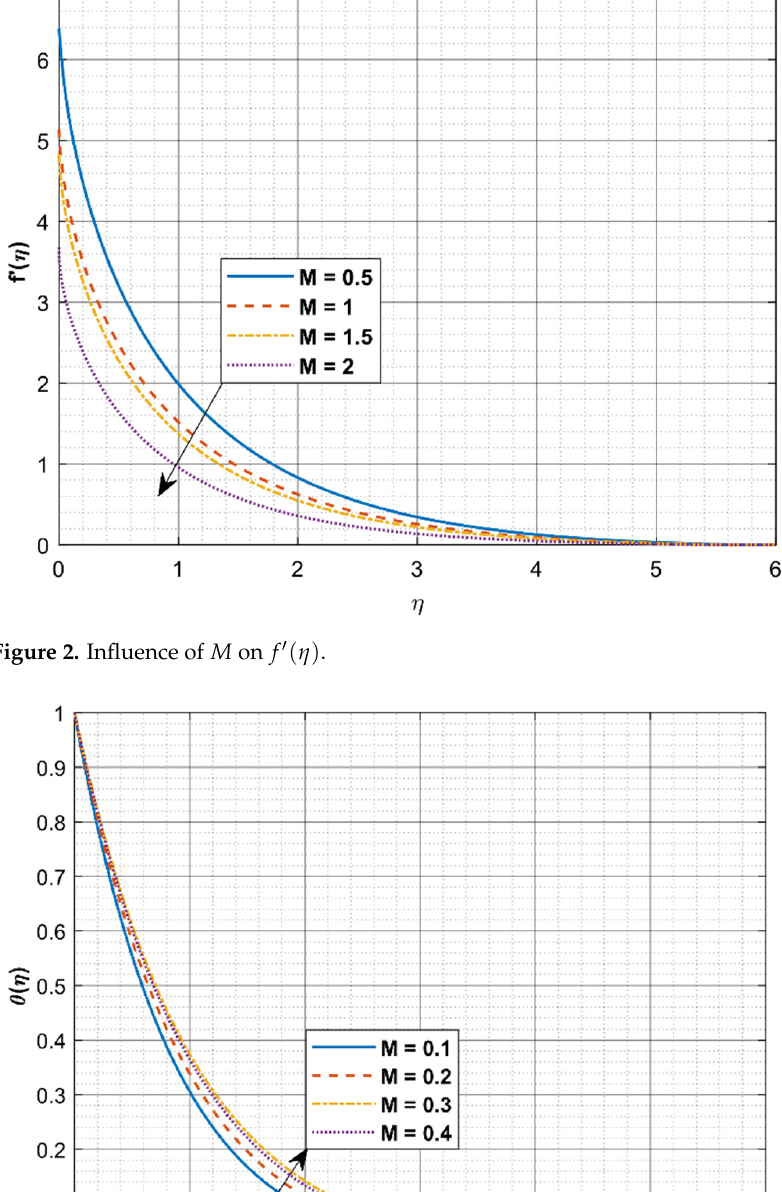
Figure 3. Influence of M on ( )